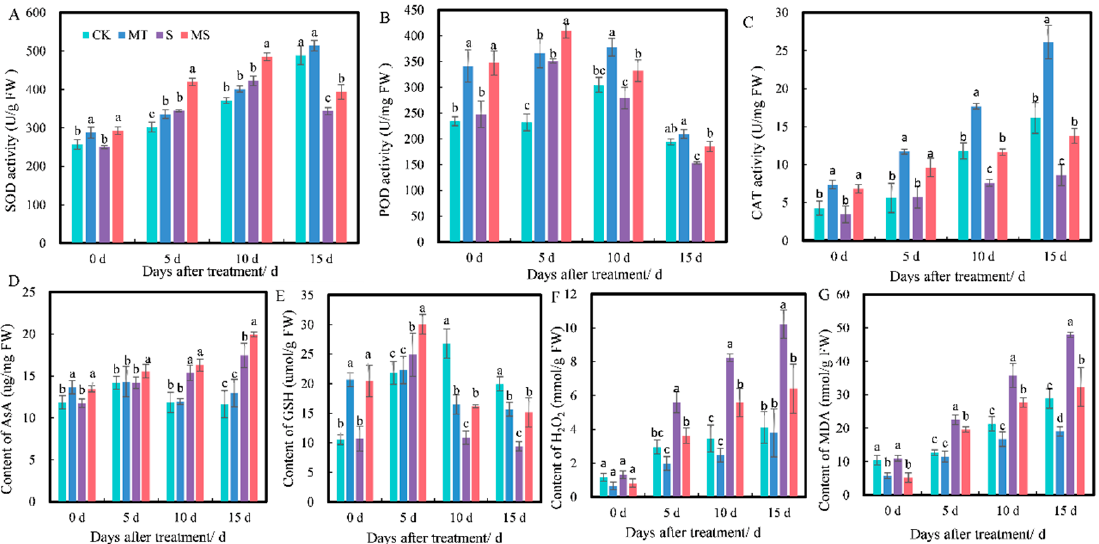
Figure 3. Effects of exogenous melatonin on ( A ) superoxide dismutase (SOD) activity, ( B ) peroxidase (POD) activity, ( C ) catalase (CAT) activity, ( D ) ascorbic acid (AsA) content, ( E ) reduced glutathione (GSH) content, ( F ) H 2 O 2 content and ( G ) malonaldehyde (MDA) content of cotton seedling roots under salt stress. Different lowercase letters indicate significant differences among treatments at the same timepoint ( p < 0.05). CK, control treatment; MT, melatonin treatment; S, NaCl treatment; MS, combined melatonin and NaCl treatment.